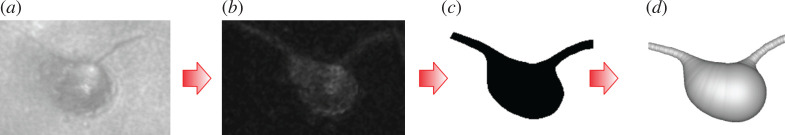
Reconstruction of three-dimensional geometry of MAs from AOSLO images. (a) The MA is imaged using AOSLO multiply scattered light (MSL) imaging modality. (b) The perfusion map of the corresponding MA is generated by analysing a sequence of MSL images using pixel-by-pixel standard deviation method. The bright region in the map highlights the region with flowing blood. (c) A binary mask of the MA and its feeding and draining vessels are created manually based on (a) and (b) using ImageJ [29]. (d) Three-dimensional models of the MA are generated under the assumption that the MA geometries are rotationally symmetric.